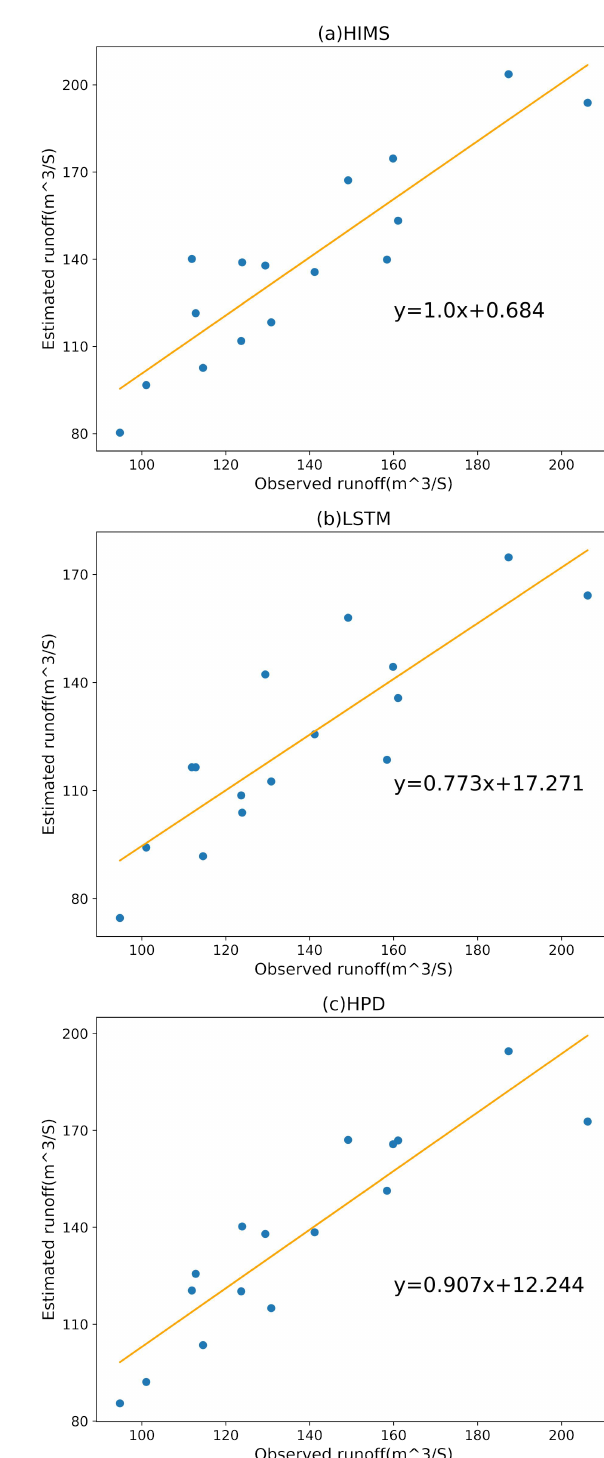
Table 1 . monthly runoff simulation.